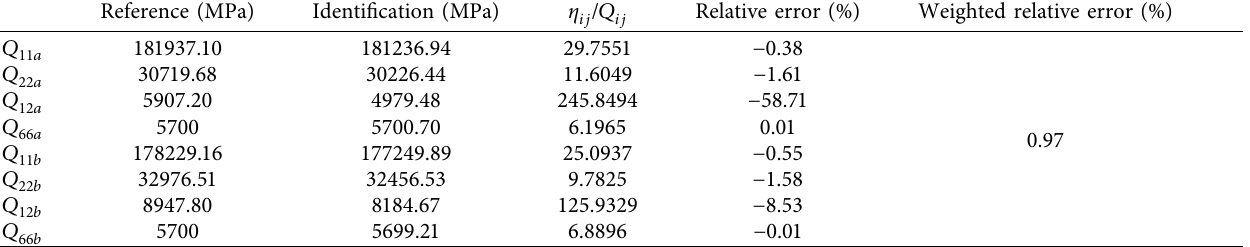
Table 4: Identification results of constitutive parameters of orthotropic bimaterial using the optimized piecewise virtual fields. Reference (MPa)